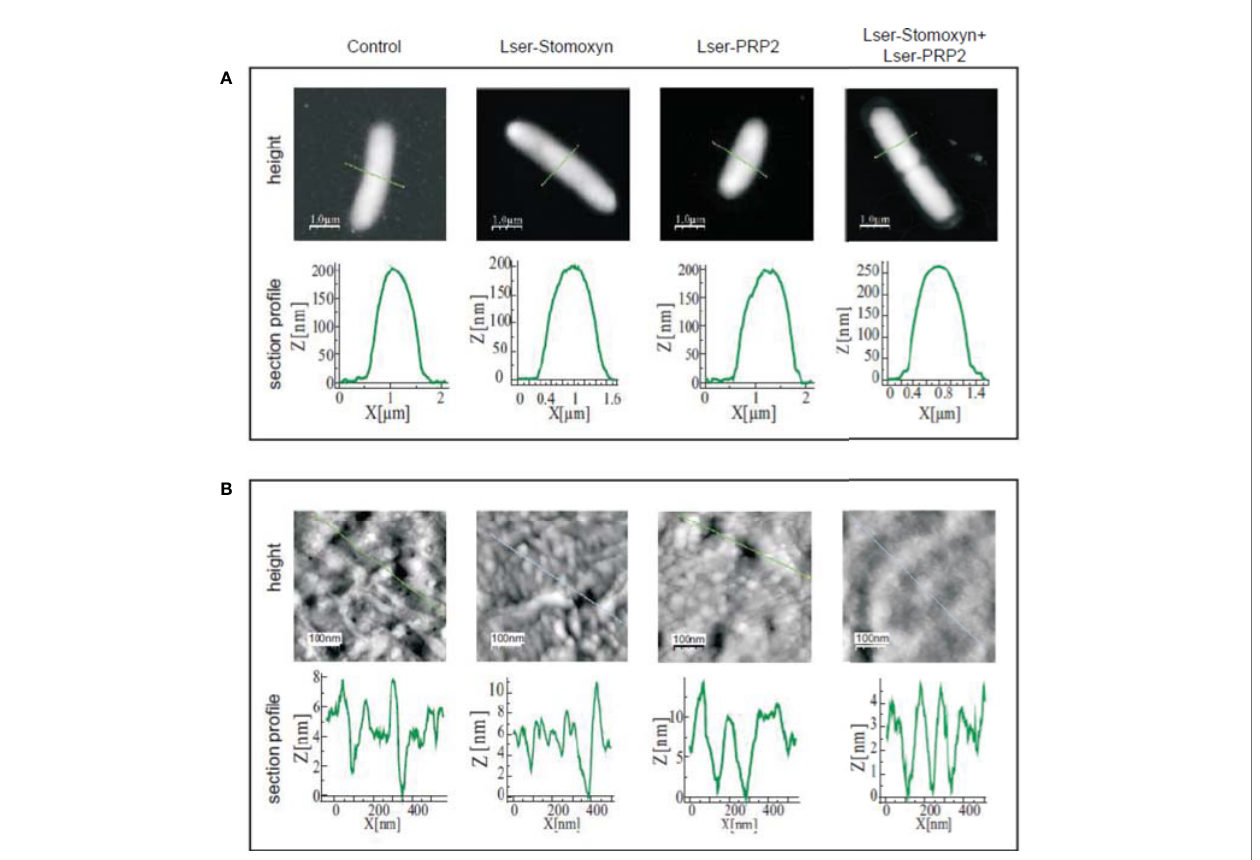
FIGURE 5 | Section pro fi les of the Escherichia coli JM83 cell surface after treatment with Lser-stomoxyn and Lser-PRP2. The bacteria were incubated alone (control) or in the presence of Lser-stomoxyn (0.25 µM), Lser-PRP2 (50 µM), or a combination of both peptides, before imaging by atomic force microscopy. The height 5×5 µm (A) and 500×500 nm (B) images of the bacterial cell surface are shown as in Figure 4 . The lower panels indicate the section pro fi les corresponding to the lines marked in the upper panels. The bars represent 1 µm (upper panels) and 100 nm (lower panels).